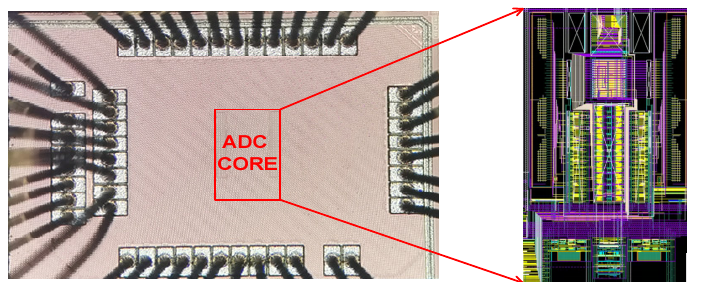
Figure 20. Chip photograph and layout of the proposed SAR ADC .